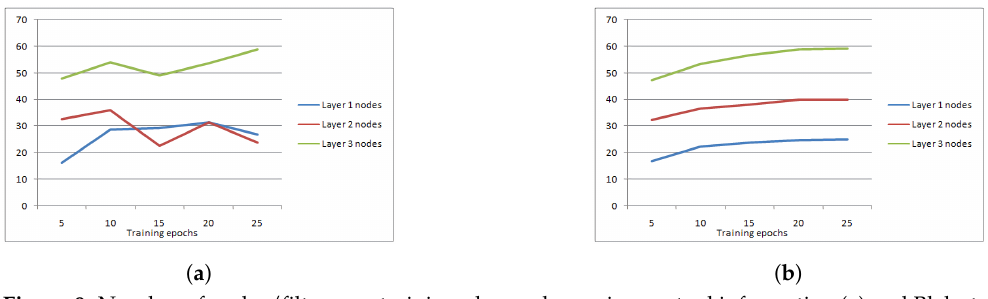
Figure 9. Number of nodes/filters per training phase when using mutual information ( a ) and Blahut– Arimoto ( b ) as an information capacity indication. The Blahut–Arimoto algorithm produces far less oscillations compared to Mutual